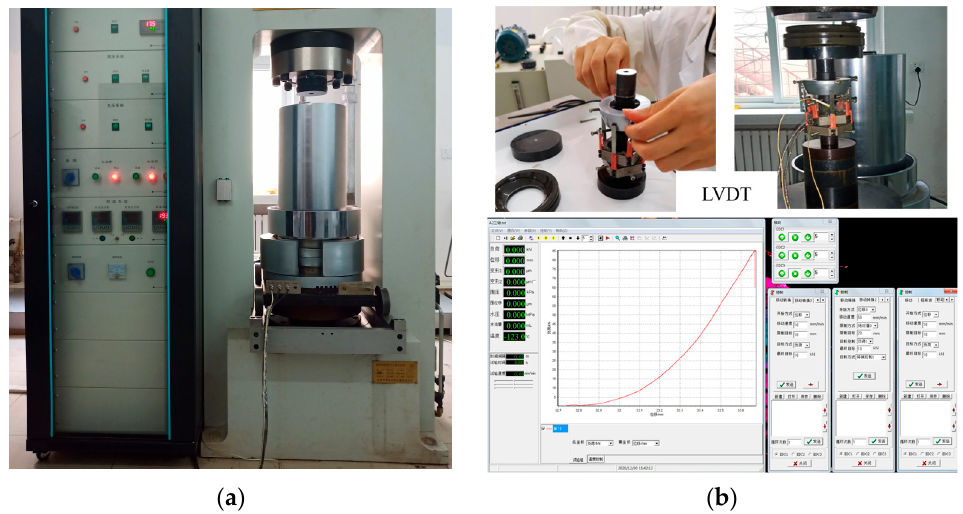
Figure 1. Rock mechanics experiment: ( a ) controlled rock triaxial testing machine by microcomputer; ( b ) software measurement and control system.